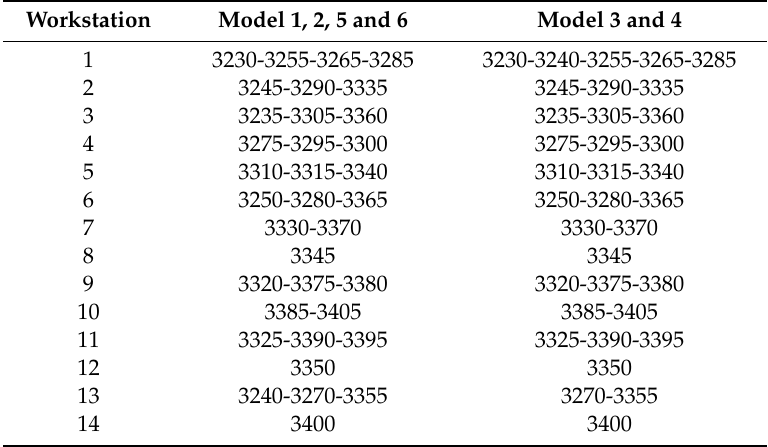
Table 13. A solution to problem from [49]. Figures represent